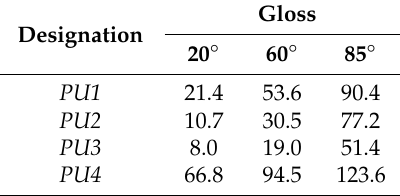
Table 3. The gloss values of wrinkled waterborne cross-linked PU at di ff erent angles of